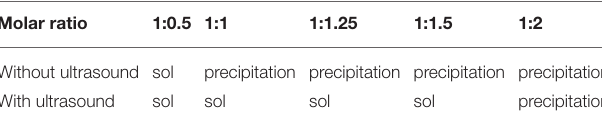
TABLE 1 | Product form in different conditions. Molar ratio Without ultrasound sol precipitation precipitation precipitation precipitation With ultrasound sol sol sol sol